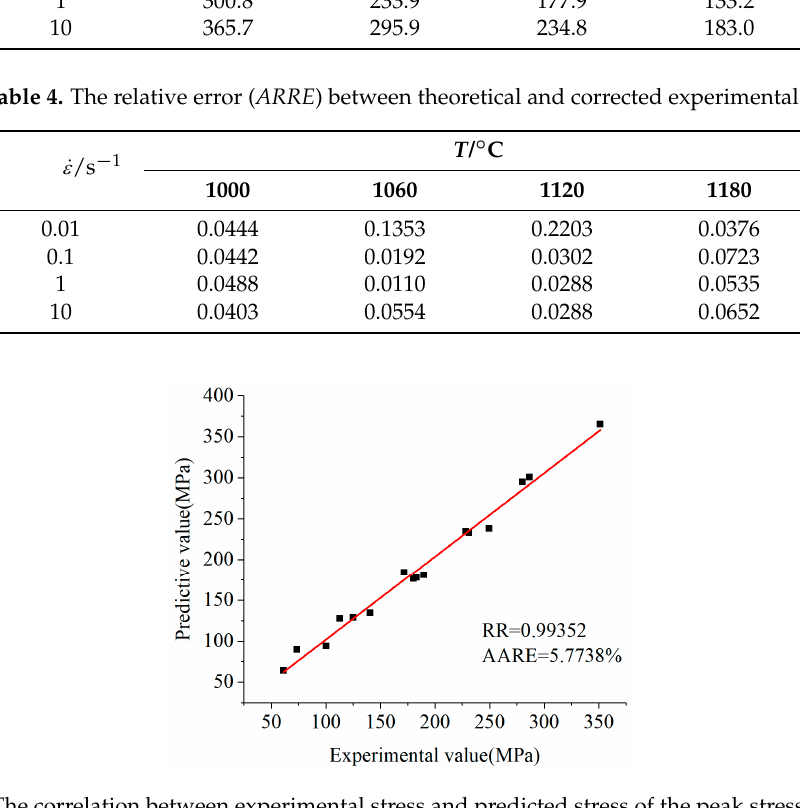
Table 3. The calculated rheological stress ( σ ) of 21-4N steel under different hot deformation conditions (MPa).